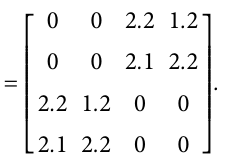
( t ) � 3 . 4 e ( t ) ,u ( t ) � 3 . 5 e ( t ) 1 1 2 2